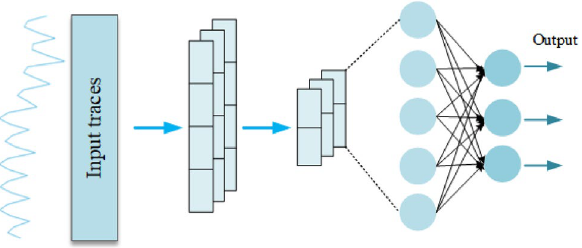
Figure 3. DL model structure.